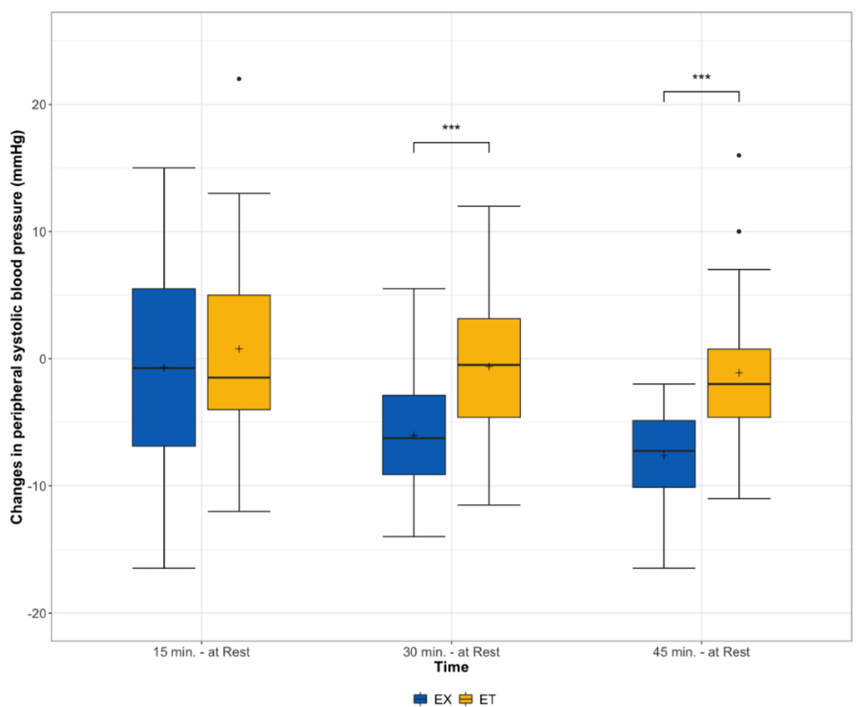
Figure 1. Changes in peripheral systolic blood pressure from rest before and 15, 30, and 45 min after exercise stratified according to the type of exercise (ET = moderate endurance exercise, EX = exergaming session), interaction effect *** = p < 0.001.